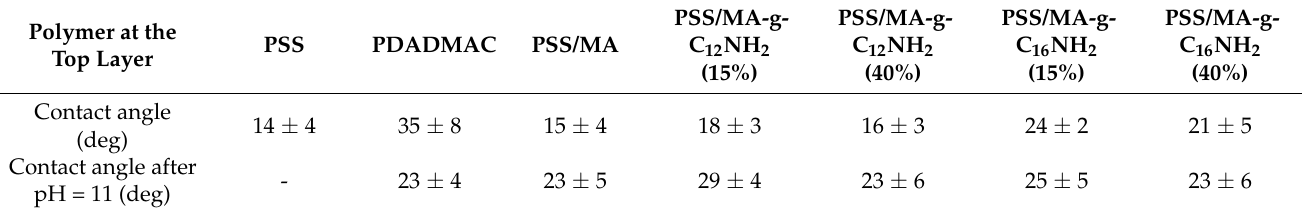
Table 2. The equilibrium contact angle of water drop at silicon wafer surface coated with the polyelectrolyte multilayer. Polymer at the Top Layer